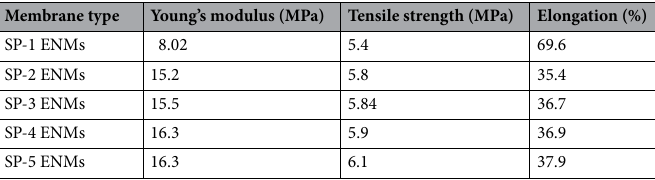
Table 3. Young modulus, tensile strength, and elongation of samples.